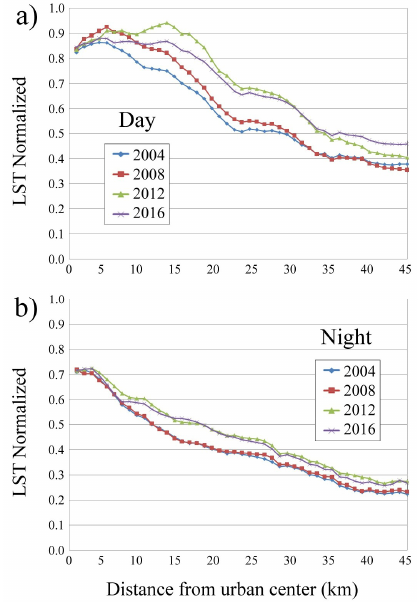
Figure 6. Mean LST n versus distance from the city center, for the years 2004, 2008, 2012, and 2016: ( a ) daytime; ( b ) night-time.